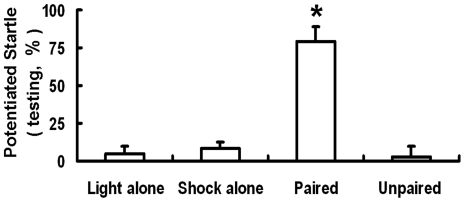
Fear-potentiated startle values in light alone, shock alone, paired CS-US and unpaired CS-US groups.Rats in the paired group received 7 light-shock pairings, whereas the unpaired rats received 7 lights and 7 shocks in a pseudorandom manner. Light alone (n = 8); shock alone (n = 8). * p<0.05, paired (n = 12) vs. unpaired (n = 8).